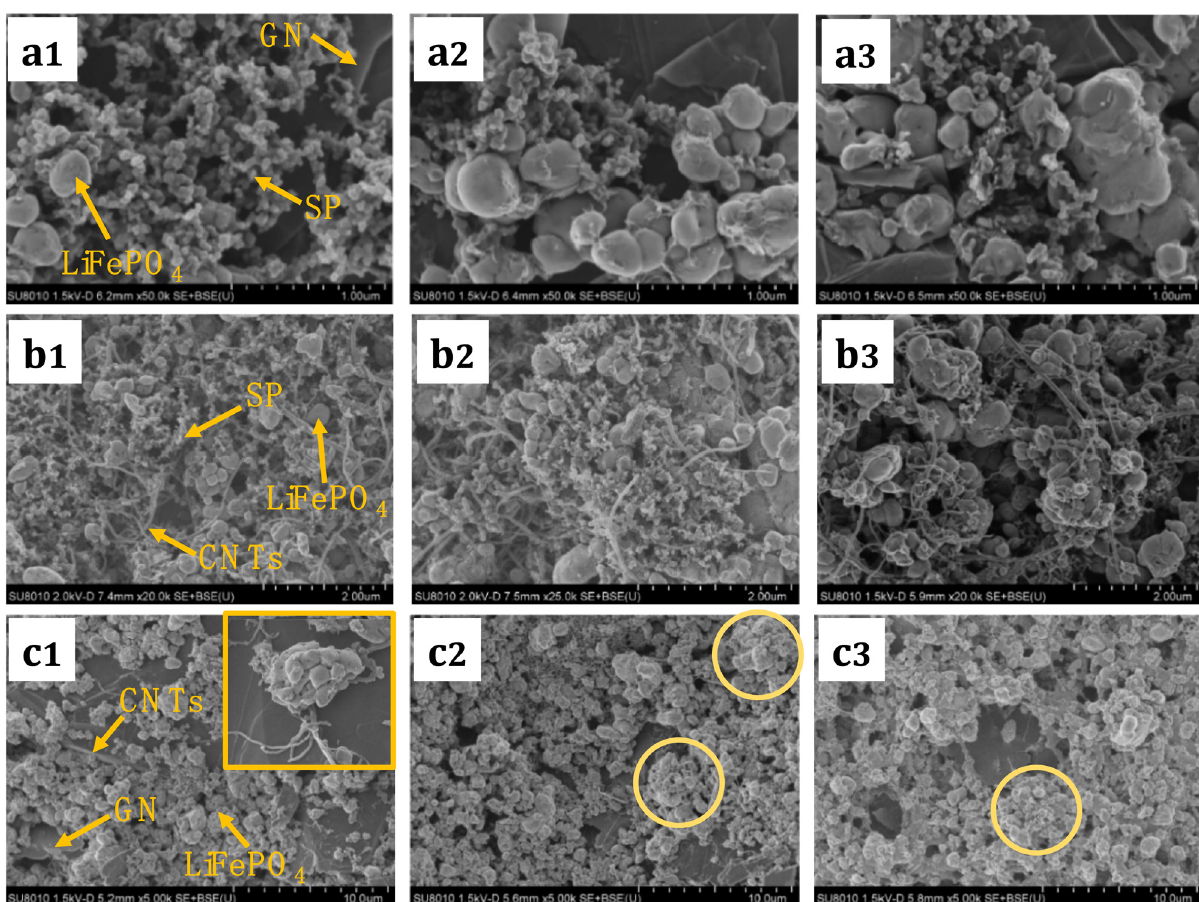
Figure 4: Surface SEM morphology of the LiFePO 4 cathode plates with various binary conductive agents in di ff erent ratios ( a1 – a3: SP - GN, b1 – b3: SP - CNT, c1 – c3: CNT - GN )